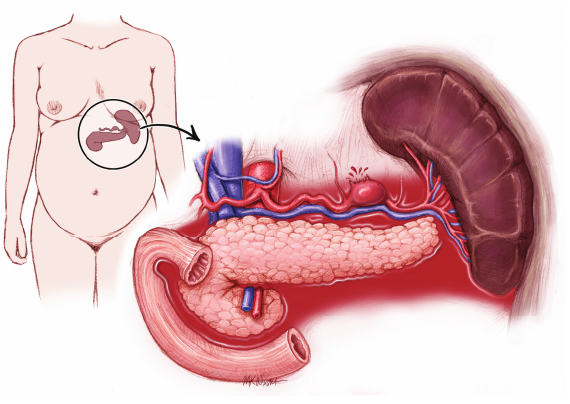
Figure 1: Rupture of splenic artery aneurysm during pregnancy.